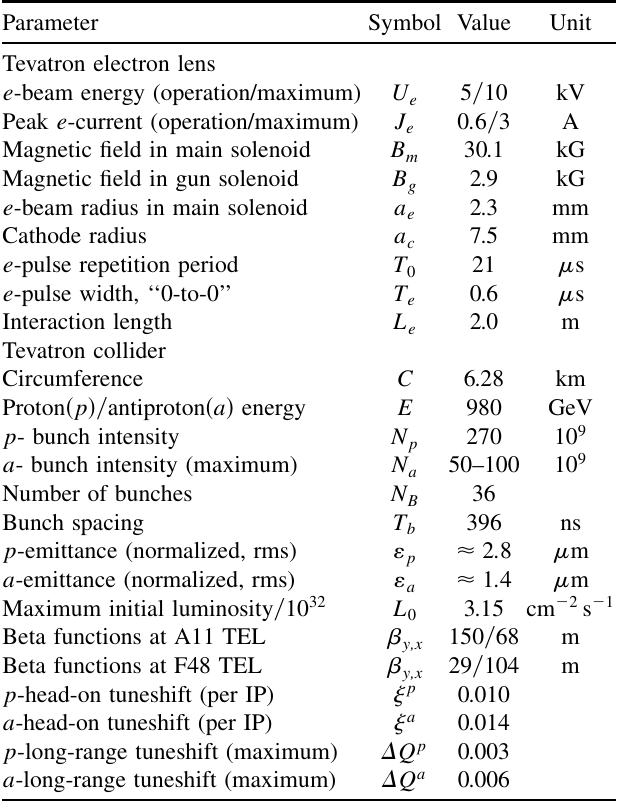
TABLE I. Electron lens and Tevatron collider